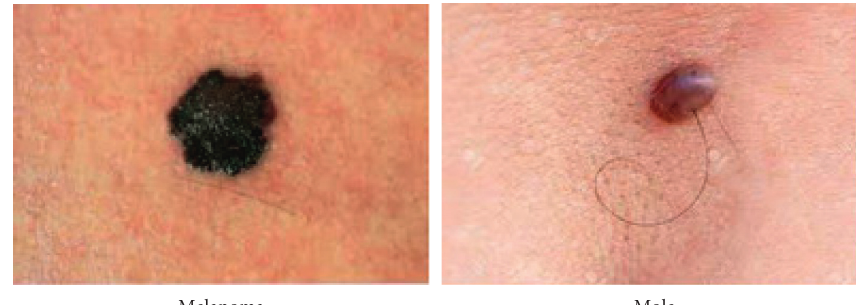
Figure 1: Difference between mole and melanoma of the